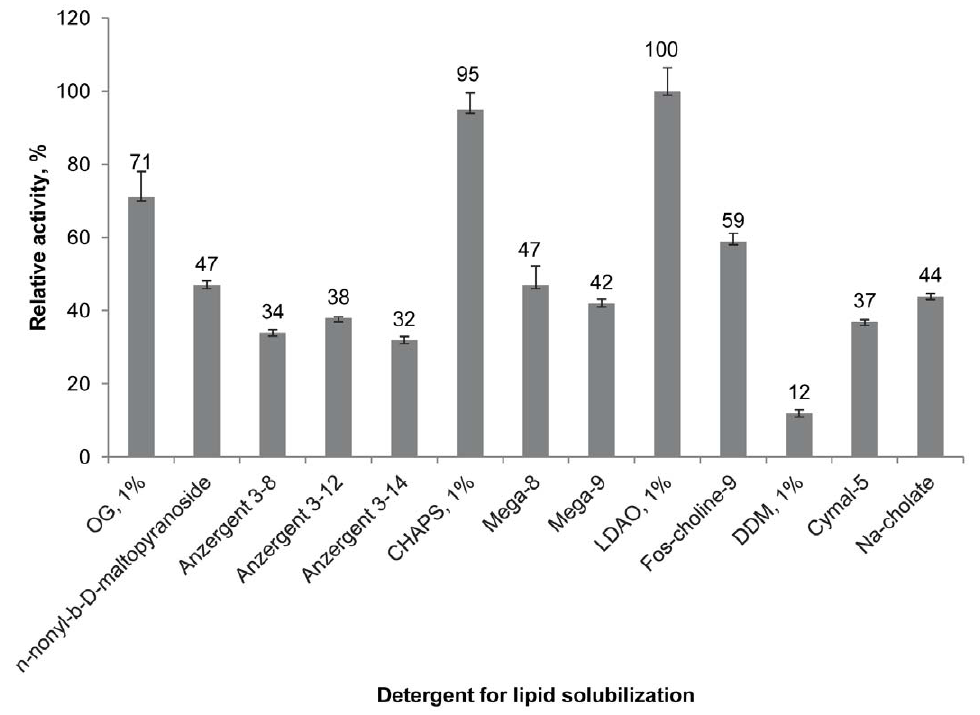
Figure 2. Recovery of functional CB 2 in proteoliposomes prepared from various dominant detergents. Activity is presented as % of the maximal activity in the series (1% LDAO). The results shown represent data 6 S.D. (error bars) of duplicate determinations from single representative experiments (out of three independently performed experiments, n=3)